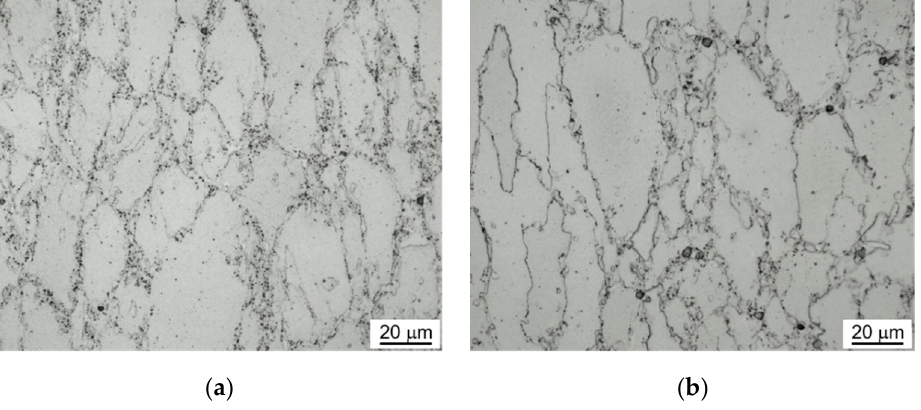
Figure 7. Effect of heat treatment on the microstructure (light microscope) of forged OP2 ( a ) 1100 °C/20 h and ( b ) 1200 °C/20 h.